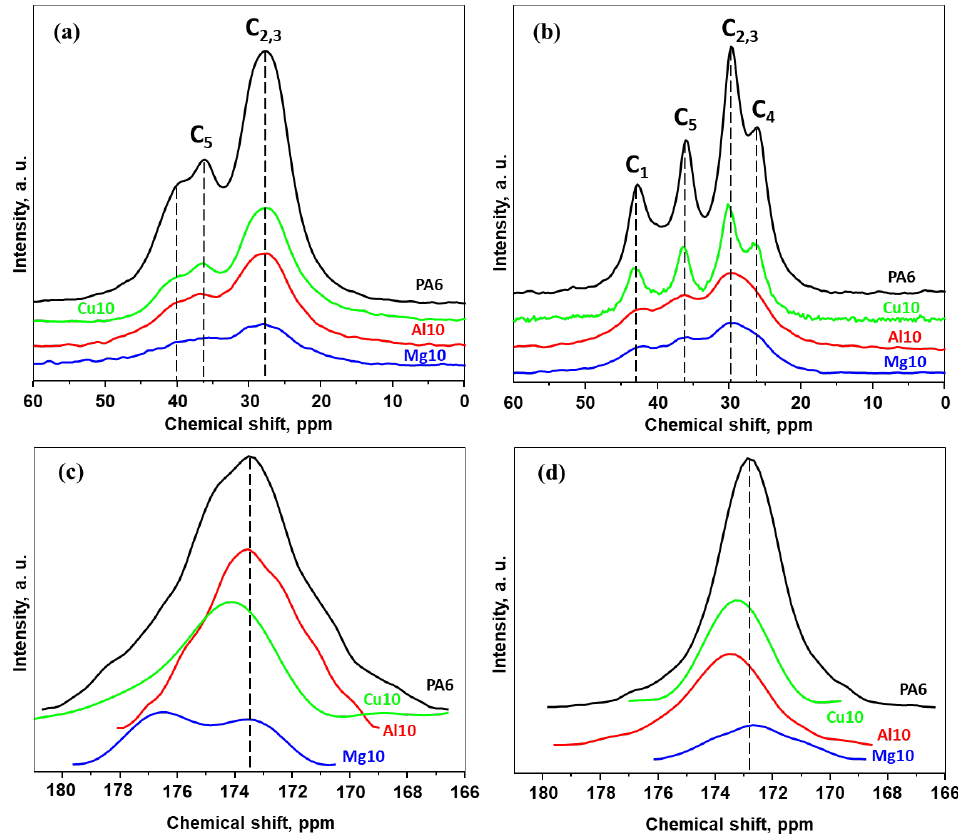
Figure 3. Evolution of the shape and position of the ssNMR signals as a function of the metal filler in 13 C MAS (left) and 13 C CP/MAS (right) with neat PA6 and Me-MP samples: ( a , b ) — C1-C5 signals; ( c , d ) — C6 signal. The curves are displaced along the Y -axis, whereby each set of curves has the same scaling of intensity. Table 2. 13 C MAS and 13 C CP/MAS chemical shifts in C nuclei obtained from MP samples. The av- erage error of the chemical shift determination is ±0.2 ppm.